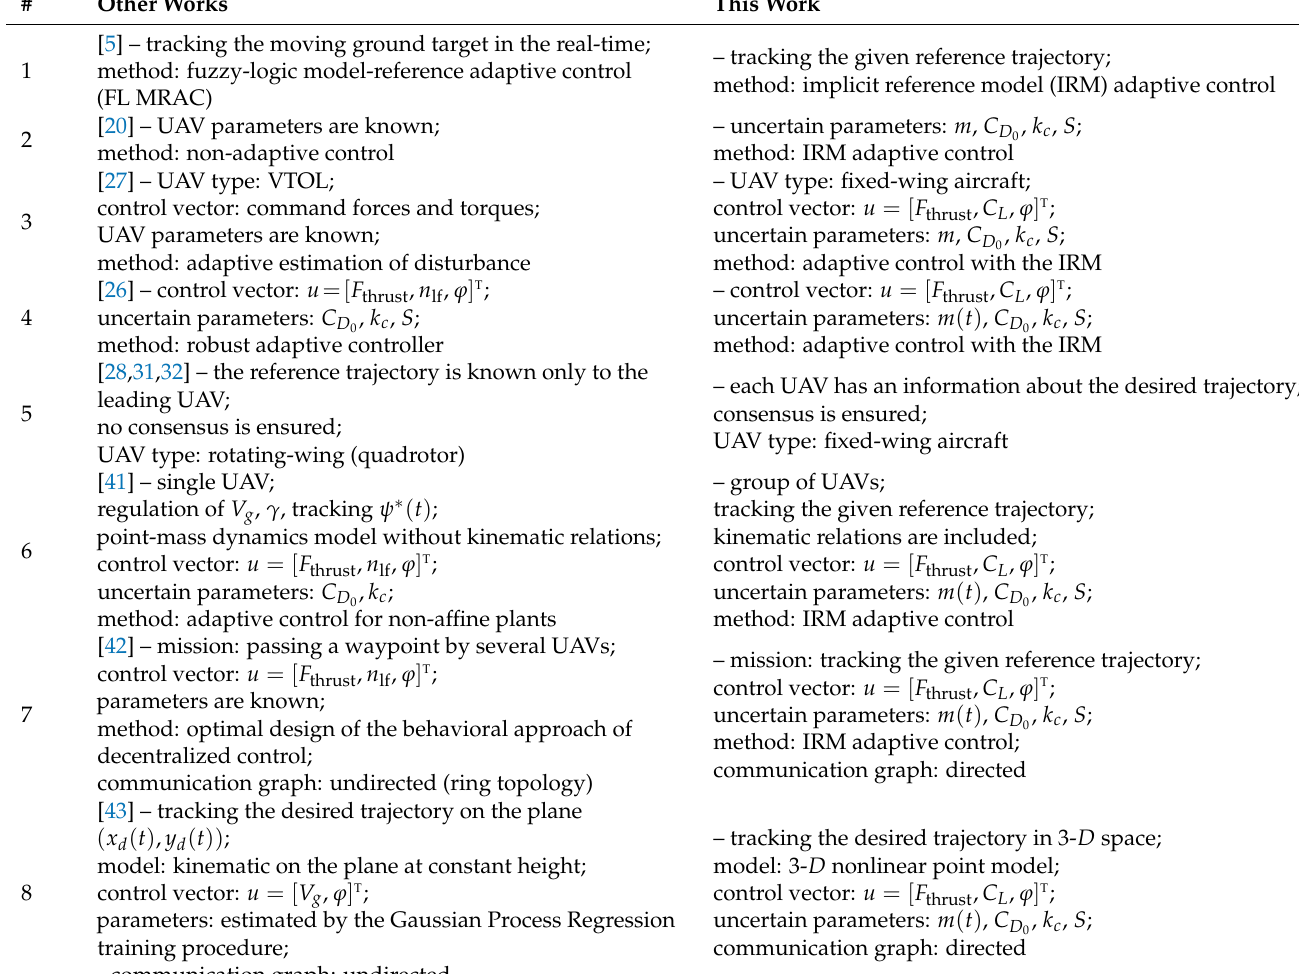
Table 1. Comparison with other